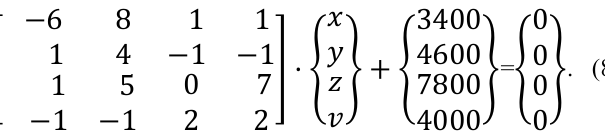
Fig. 9. The solution convergence using the technique rooted in the approximation solution projections analysis (1)–(5) and SLESR extrapolation.